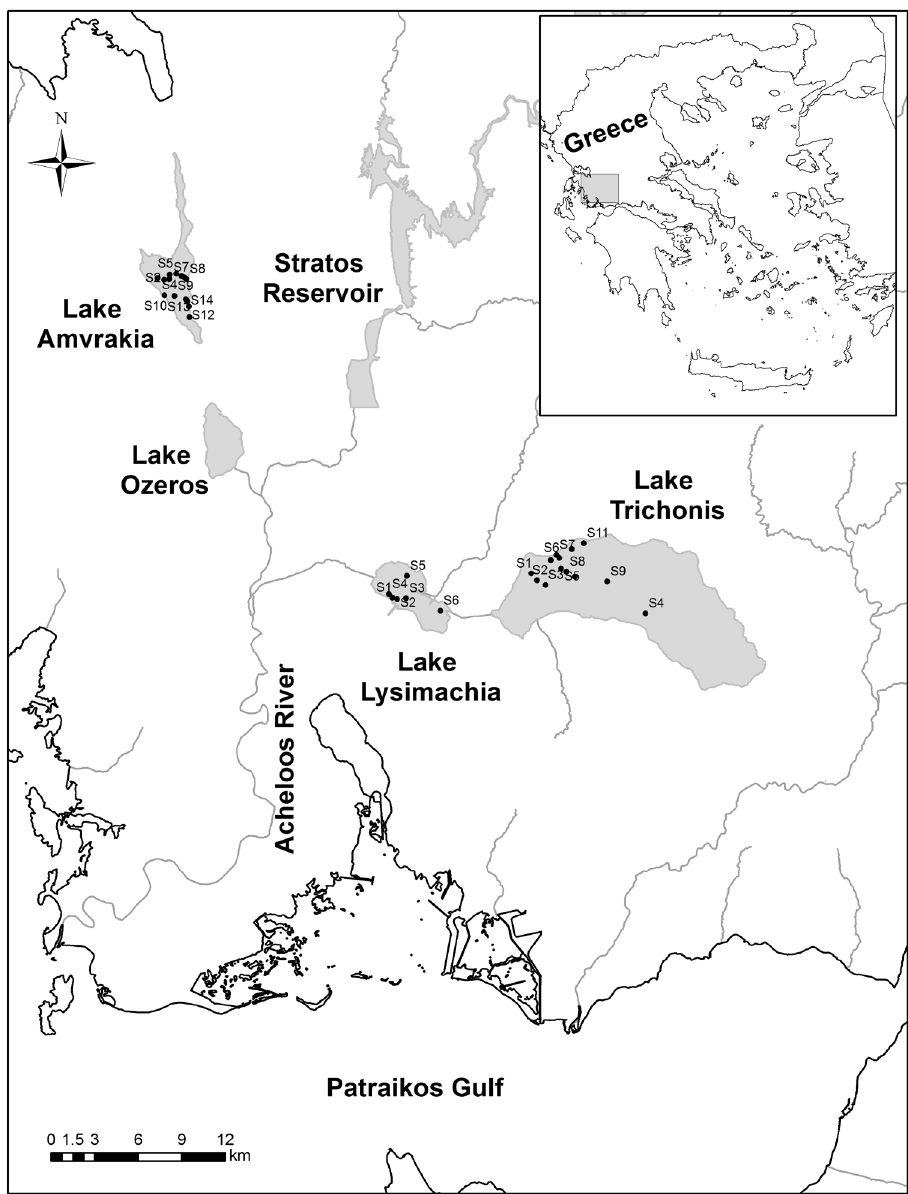
Figure 1. Geographical location of the studied lakes and sampling